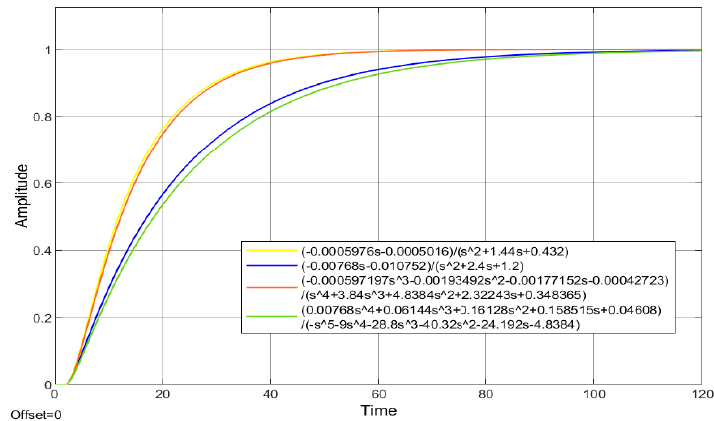
Figure 14. Simulated response under a desired reference step using different controllers.